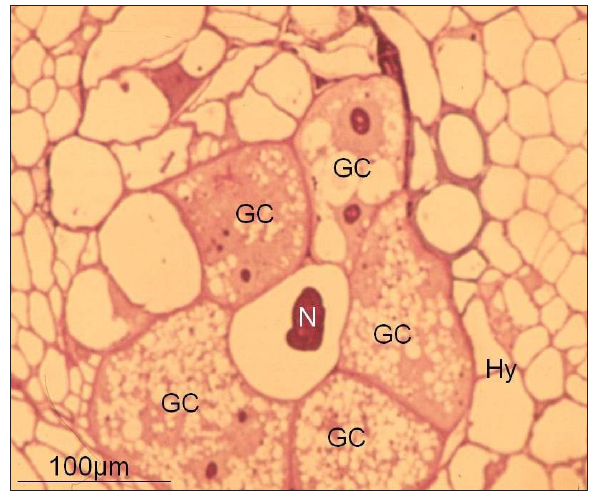
Figure 4: A light-microscope micrograph of a transverse section showing five distinct and optimal giant cells visible in the mature provascular cylinder in the root of a susceptible soybean cultivar 10 days after inoculation with Meloidoyne incognita second-stage juveniles (J2s).